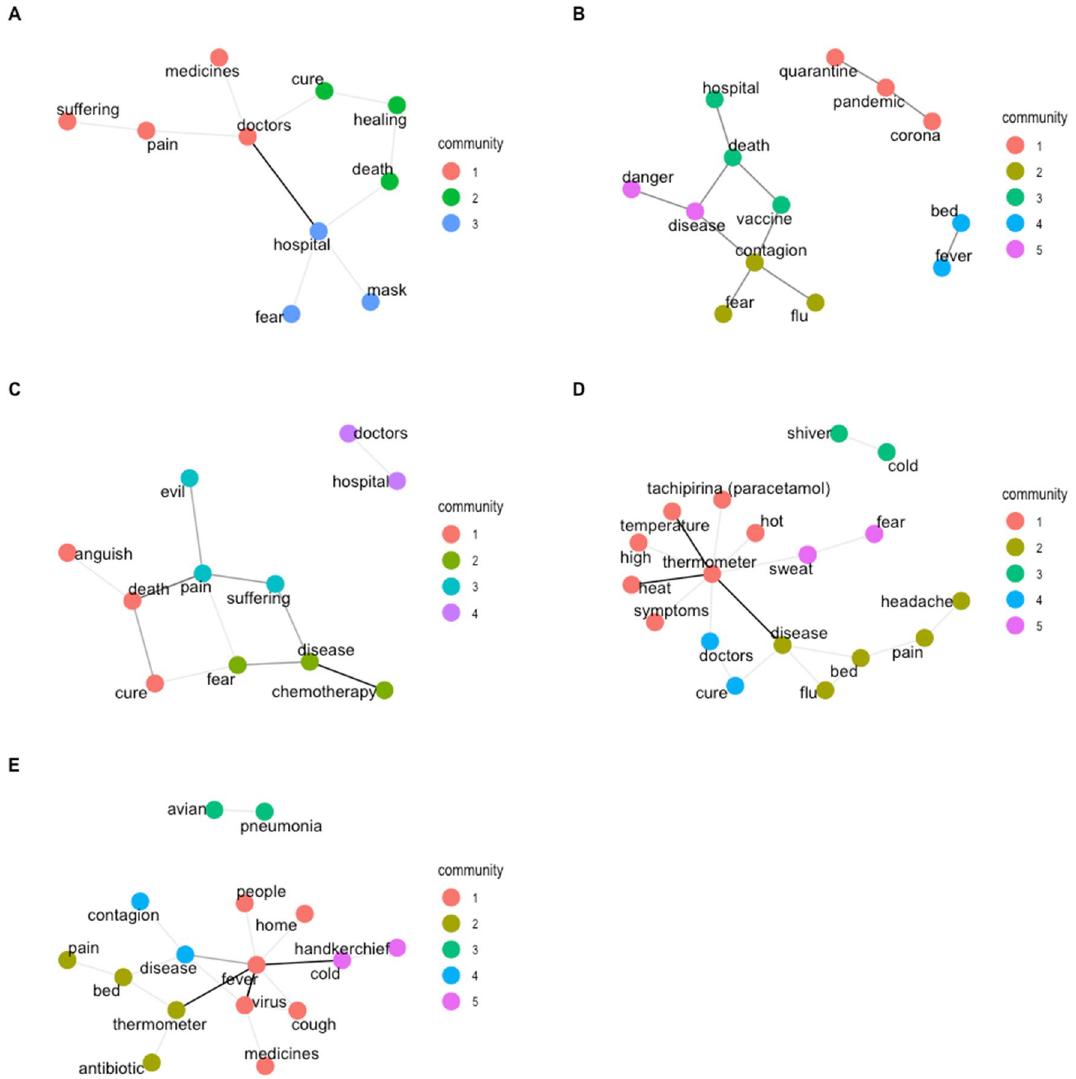
Figure 2. Networks of words (translated in English) produced by participants in relation to disease ( A ), virus ( B ), tumor ( C ), fever ( D ), and flu ( E ). Thicker links represent bigrams that co-occurred most frequently. Colors of communities are randomly assigned across networks, so they do not indicate similarities across